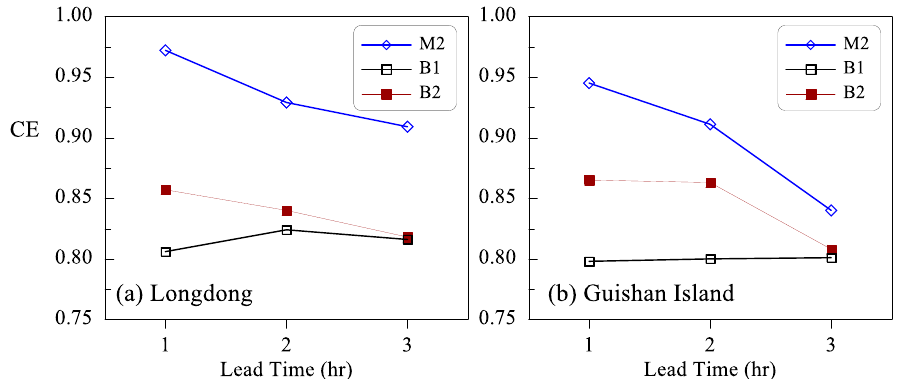
Figure 11. Forecasting performance in terms of CEs for backup systems during the validation phase for ( a ) Longdong and ( b ) Guishan Island.